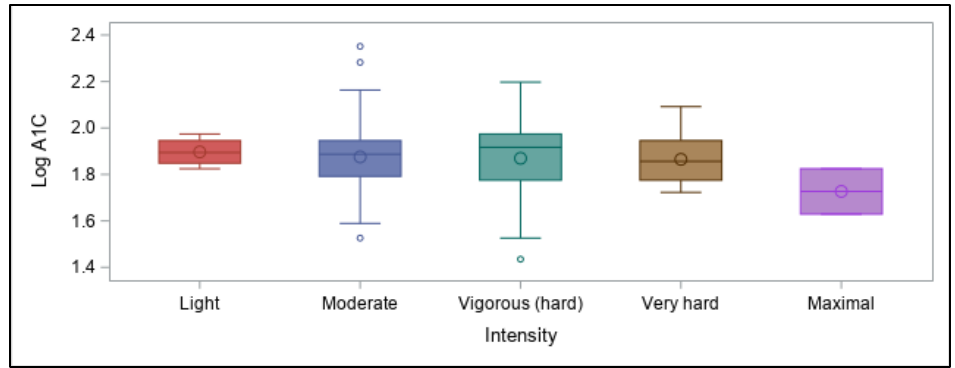
Figure 5. Intensity of physical activity and association with log A1C values.